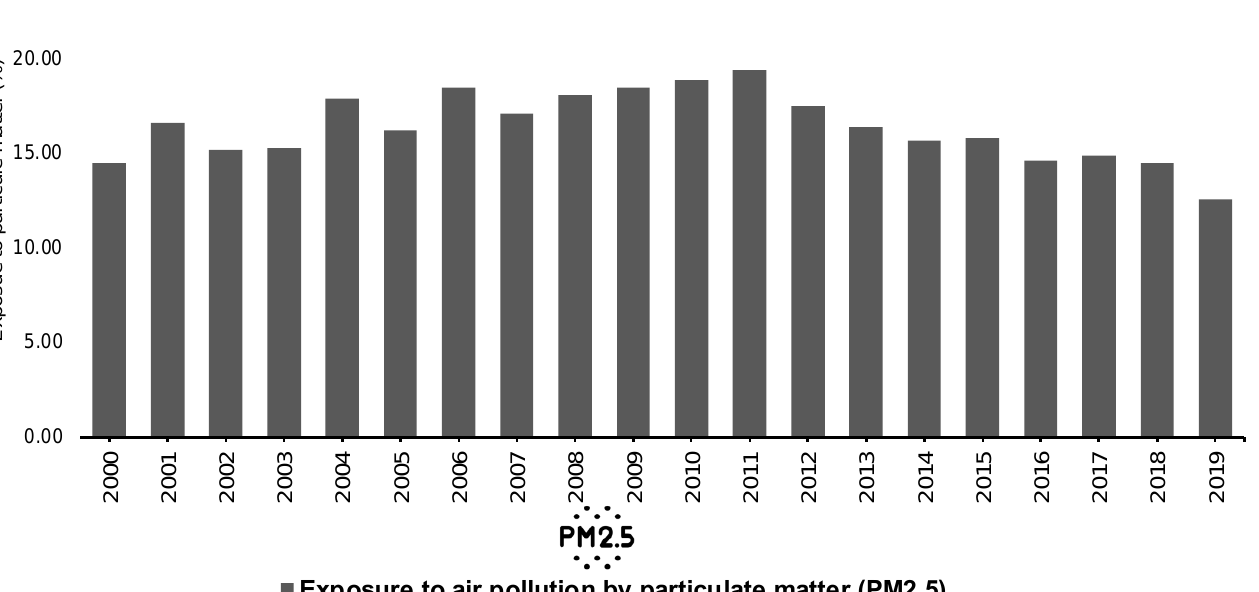
Figure 2. Exposure to air pollution by particulate matter (PM2.5) in the EU-27 between 2000–2019. This figure was created by the authors with data from Eurostat [7].